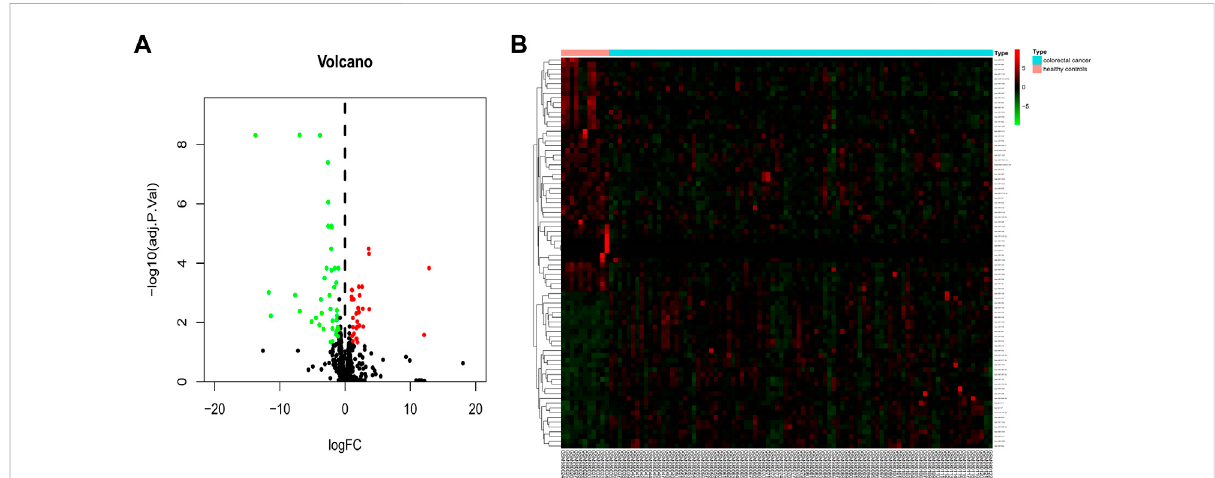
FIGURE 1 Identi fi cation of 82 DE miRNAs. Identi fi cation of differentially expressed exosomal miRNAs in colorectal cancer and healthy human blood. (A) Volcano map of genome-wide DE miRNAs. (B) Heatmap showing the total upregulated and downregulated miRNAs screened. Green and red represent downregulated and upregulated miRNAs, respectively. miRNAs, microRNAs.